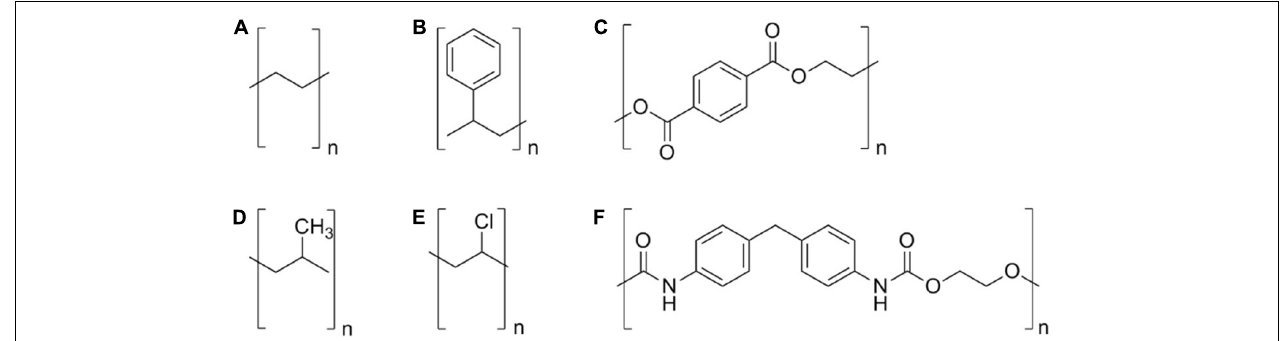
FIGURE 4 | Molecular structure of plastic polymers. (A) Polyethylene, (B) polystyrene, (C) poly(ethylene terephthalate), (D) polypropylene, (E) polyvinyl chloride, and (F) polyurethane.